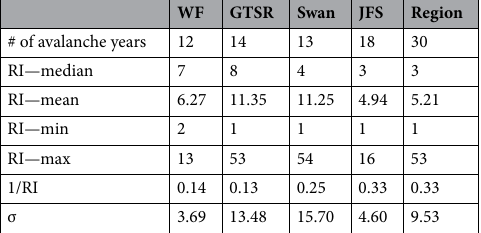
Table 1. Avalanche chronology characteristics for the various sub-regions and overall region. RI = return